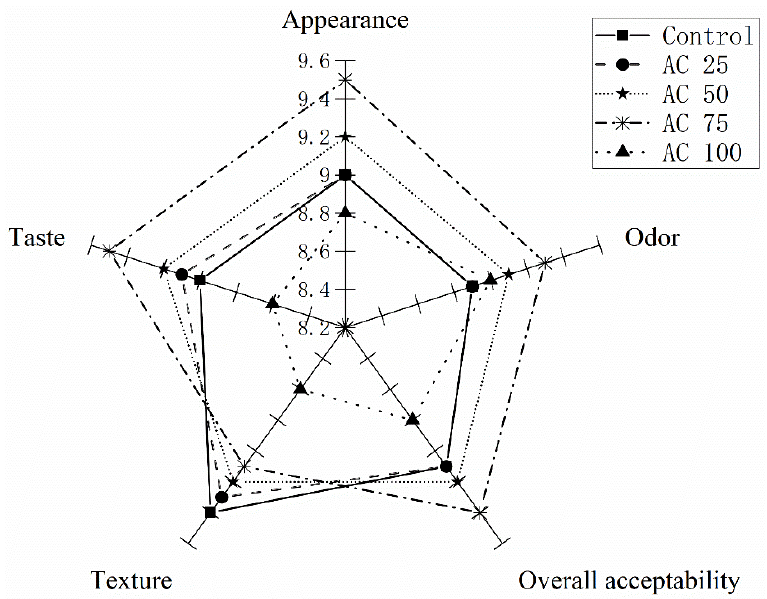
Figure 1. Sensory evaluation for the replacement of pork fat with AC in sausages. Table 4. Free amino acids (expressed as g/100 g of sausage) profile of sausages with substitution of pork fat by Auricularia cornea (AC).